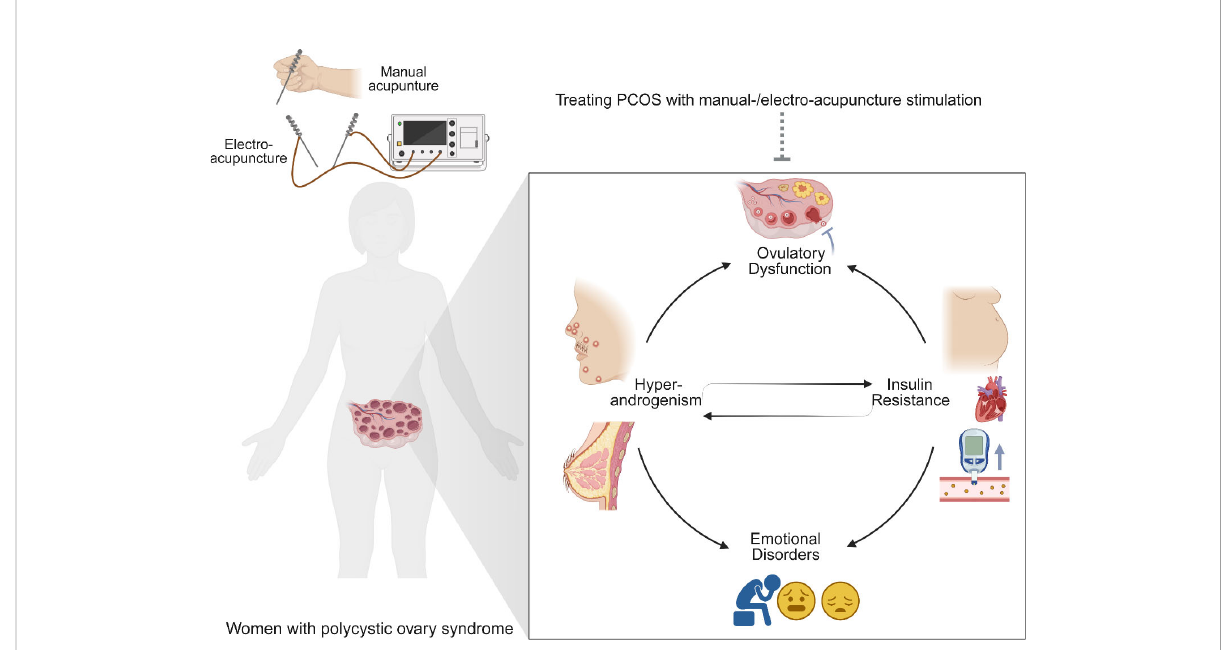
FIGURE 2 Acupuncture treatment attenuates the major clinical manifestations of polycystic ovary syndrome (PCOS). PCOS is featured by hyperandrogenism (hirsutism, acne, alopecia, etc.), ovulatory dysfunction, polycystic ovaries, obesity, insulin resistance, metabolic dysfunction, and emotional disorders. Manual-/electro-acupuncture improves the PCOS-related symptoms through different biological